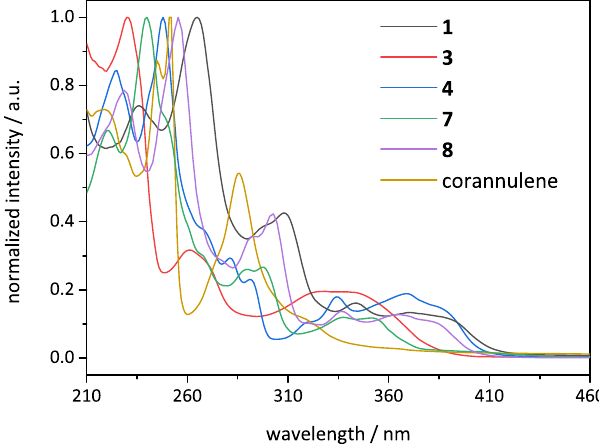
Fig. 8 Absorption characteristics of the synthesised compounds. UV-Vis spectra of compounds 1 (black line), 3 (red line), 4 (blue line), 7 (green line), 8 (violet line) and corannulene (orange line) in acetonitrile at room